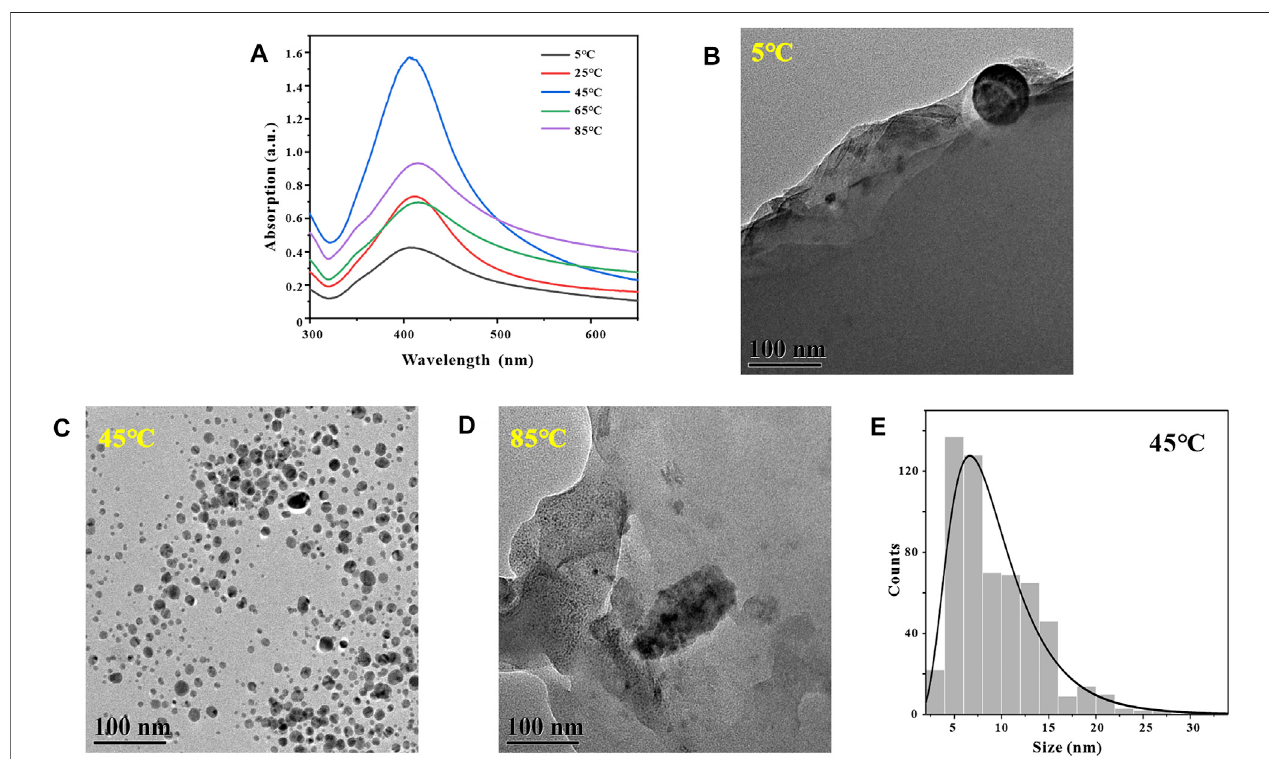
FIGURE3| Optimizationofreactiontemperatures,UV-visspectraofGO-AgNPsunderdifferentreactiontemperaturesconditions (A) ,TEMimageofGO-AgNPsat reaction temperature T = 5 ° C (B) , T = 45 ° C (C) , and T = 85 ° C (D) , panel (E) is the particle size distributions of AgNPs in panels (C)